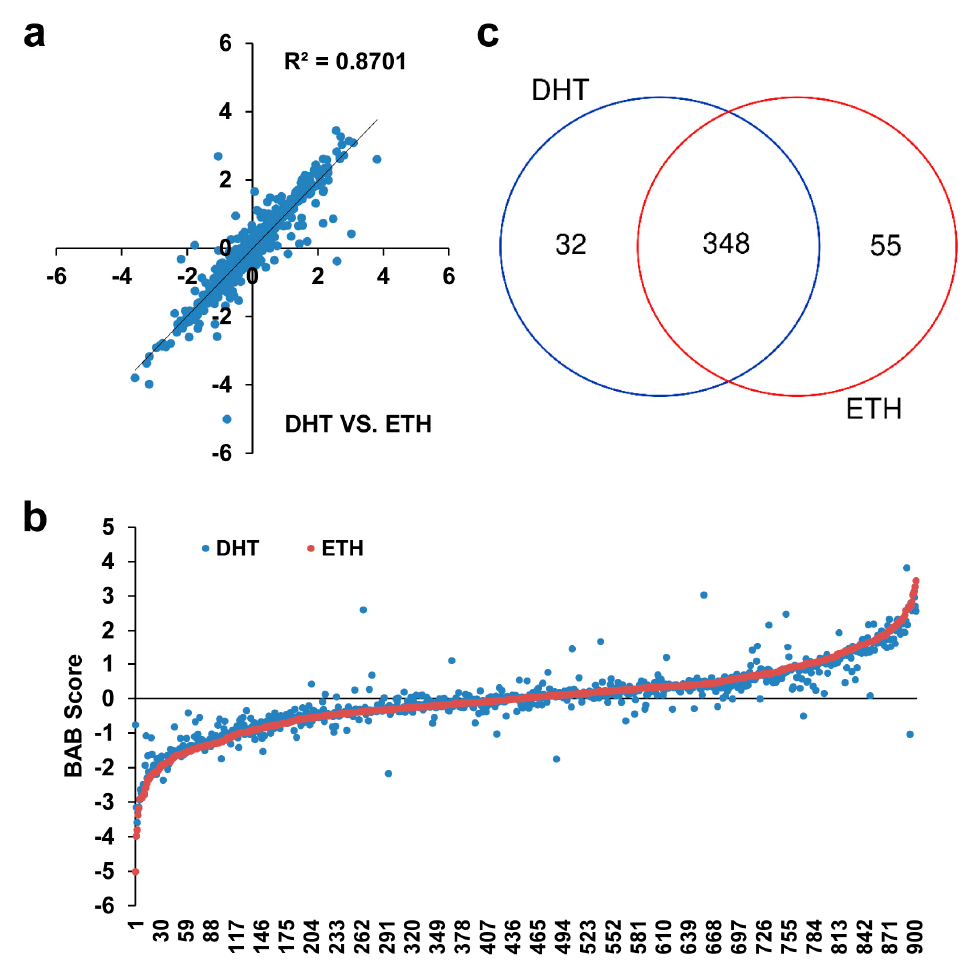
Figure 3. Correlation and distribution of biased allelic binding (BAB) score. ( a ) Correlation of BAB scores between DHT and ETH groups. ( b ) BAB score distribution in DHT and ETH groups (sorted by BAB score from low to high in ETH group). ( c ) Overlap of significant SNPs (absolute BAB score ≥ 0.58) between DHT and ETH